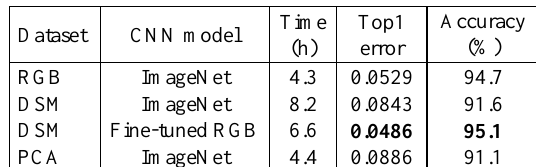
Table 1. The comparison parameters of fine-tuned models